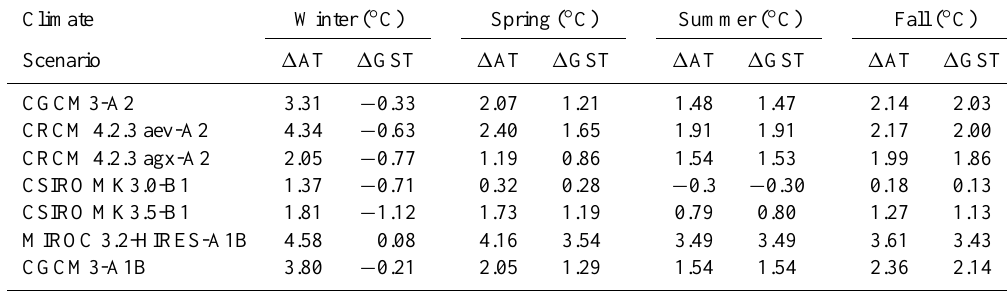
Table 2. Changes in seasonal ∗ AT and ForHyM2-simulated GST for each climate scenario. Climate Winter ( ◦ C) Spring ( ◦ C) Summer ( ◦ C) Fall ( ◦ C) Scenario 1 AT 1 GST